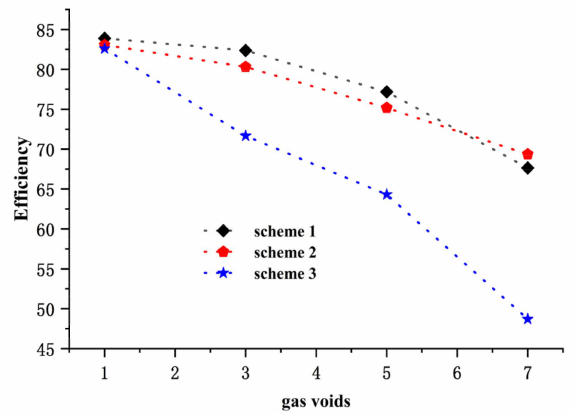
Figure 6. The e ffi ciency of each scheme under di ff erent inlet gas volume